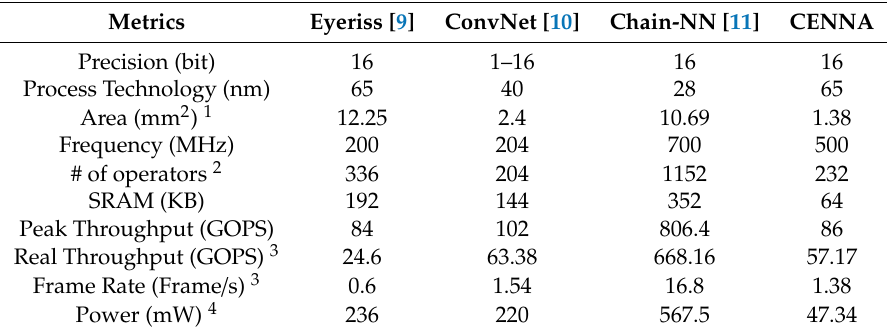
Table 7. Performance comparison with PE-array based